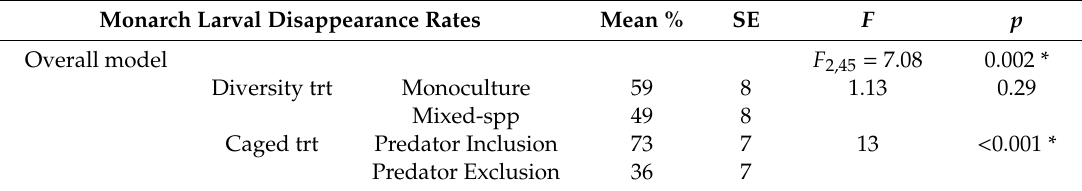
* indicates a statistical di ff erence ( p <